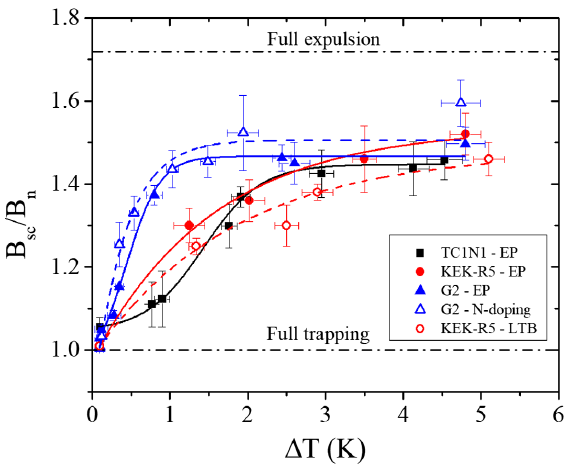
FIG. 5. Average flux expulsion ratio at the equator as a function of the temperature difference (iris-to-iris) on cavities after EP surface treatment, N-doping (G2), and LTB (KEK-R5). The lines are sigmoidal fits to the data and are a guide to the